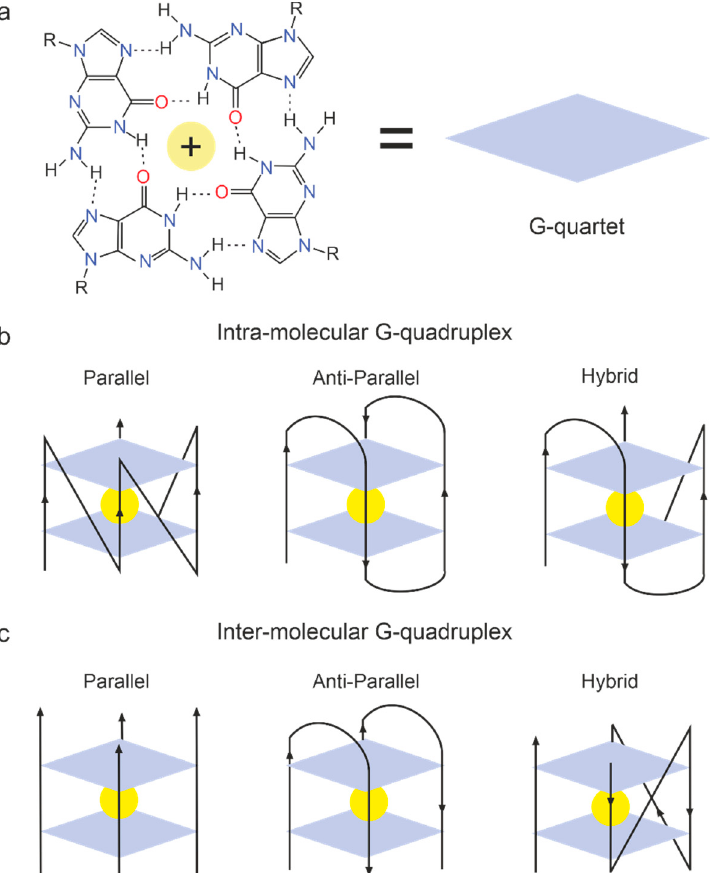
Figure 3. ( a ) The G-quartet structure formed by Hoogsteen base pairing of four guanine residues. ( b ) The intra-molecular topology of the G-quadruplex structure forms parallel, anti-parallel, and hybrid conformations. ( c ) The inter-molecular topology of the G-quadruplex structure forms parallel, anti-parallel, and hybrid conformations.